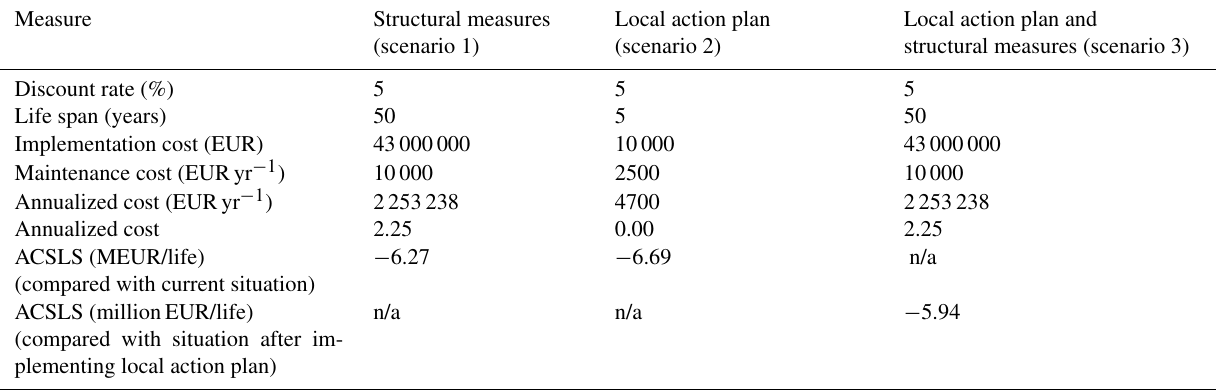
Table 7. Results from evaluation of risk reduction measures.